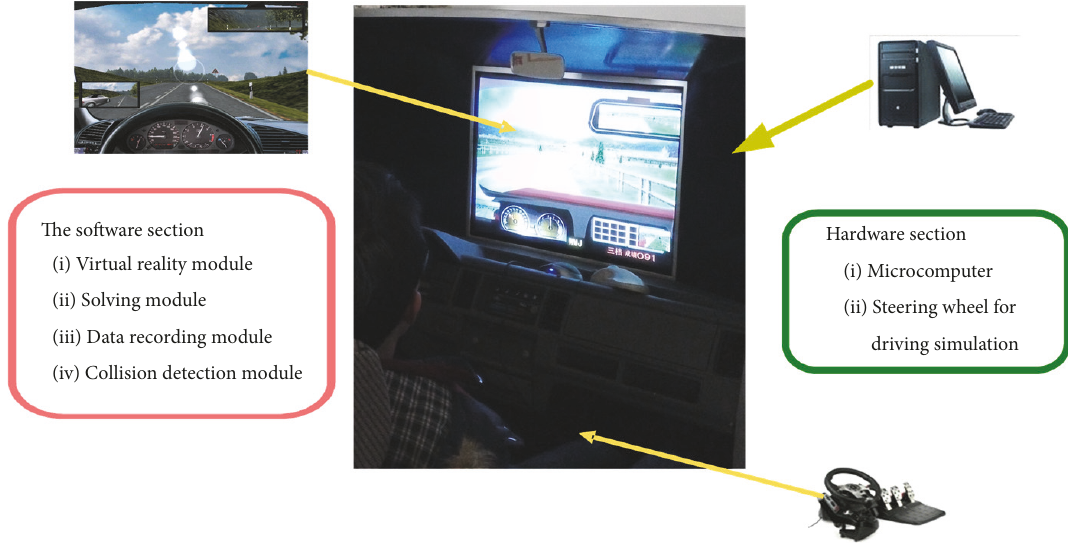
Figure 5: The driving